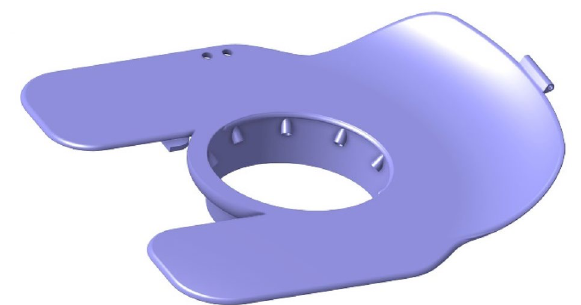
Fig. 4 Design of a WCS commode seat—an isometric view